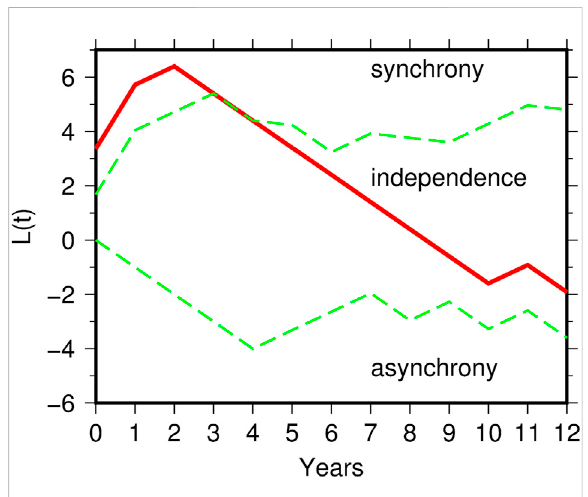
FIGURE 3 Test for synchronization between the earthquakes E1 – E6 in Figure 2 and the peak of the scPDSI in each of the fl uctuations F1 – F6. The three curves indicate the statistic L(t) (continuous line) and its 95% con fi dence envelope (dashed